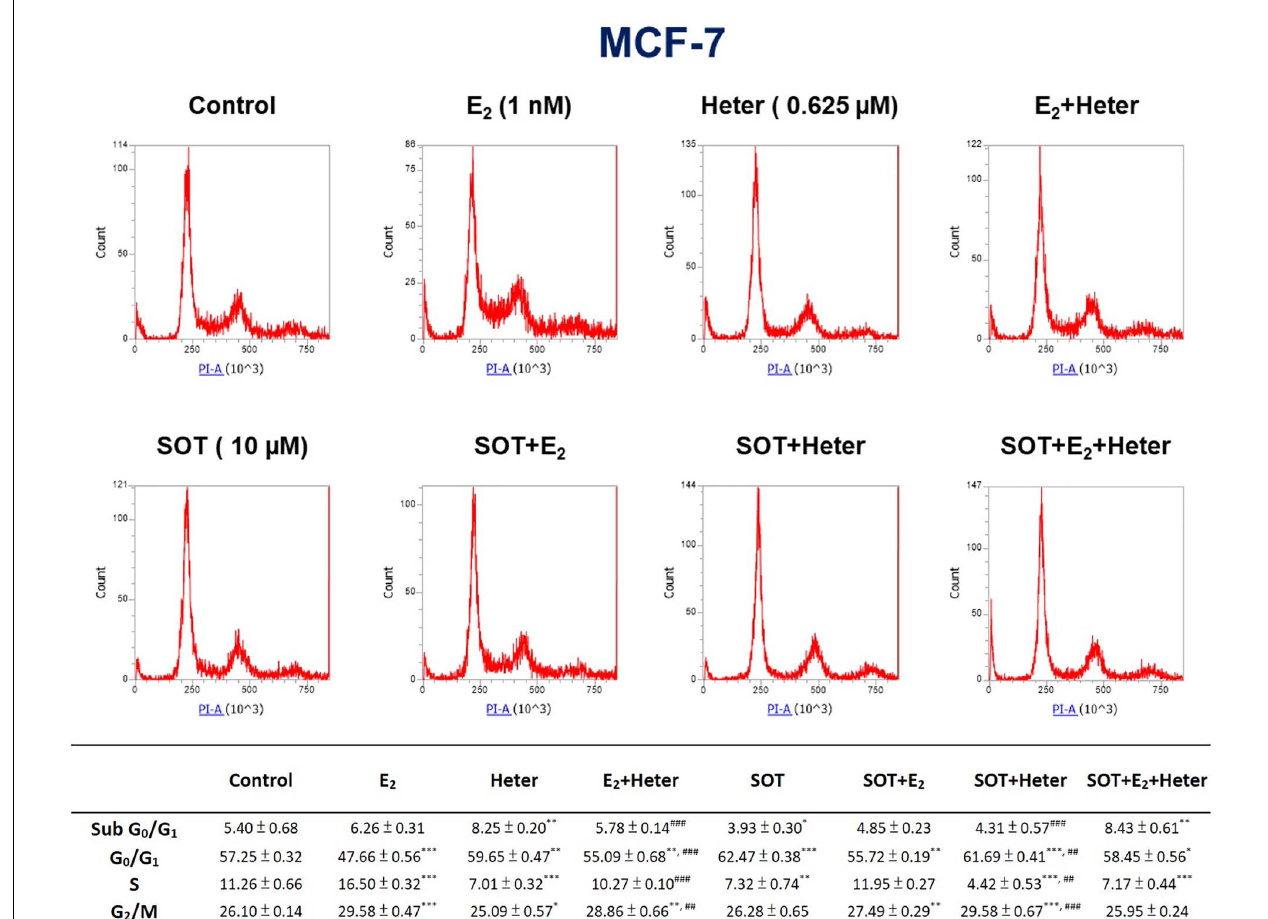
FIGURE 6 | Estrogen, heteronemin, and sotrastaurin (SOT) affect proliferation that induces apoptosis and cell cycle arrest in breast cancer cells. MCF-7 cells were treated with 1 nM E 2 , 0.625 µ M heteronemin in the presence and absence of 10 µ M SOT for 24 h. Cells were harvested, and a flow cytometric assay was conducted as described in section “Materials and Methods.” n = 3. ∗ p < 0.05, ∗∗ p < 0.01, ∗∗∗ p < 0.001, compared to the untreated control. ## p < 0.01, ### p < 0.001, compared to heteronemin treatment